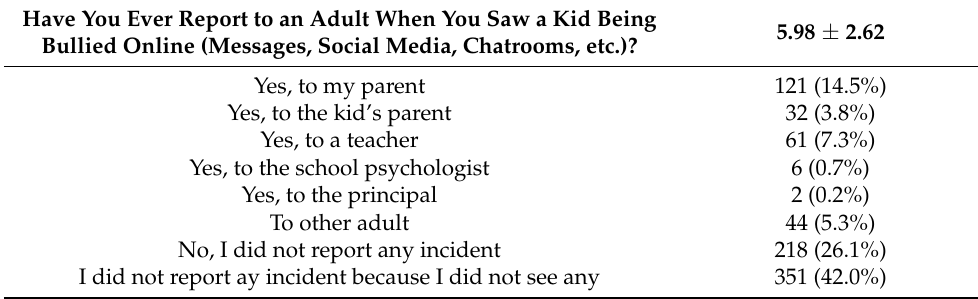
Table 4. Reporting a cyberbullying behaviour 1